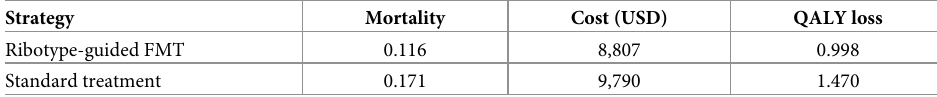
Table 2. Base-case results of expected mortality, cost, and quality-adjusted life-year (QALY) loss.